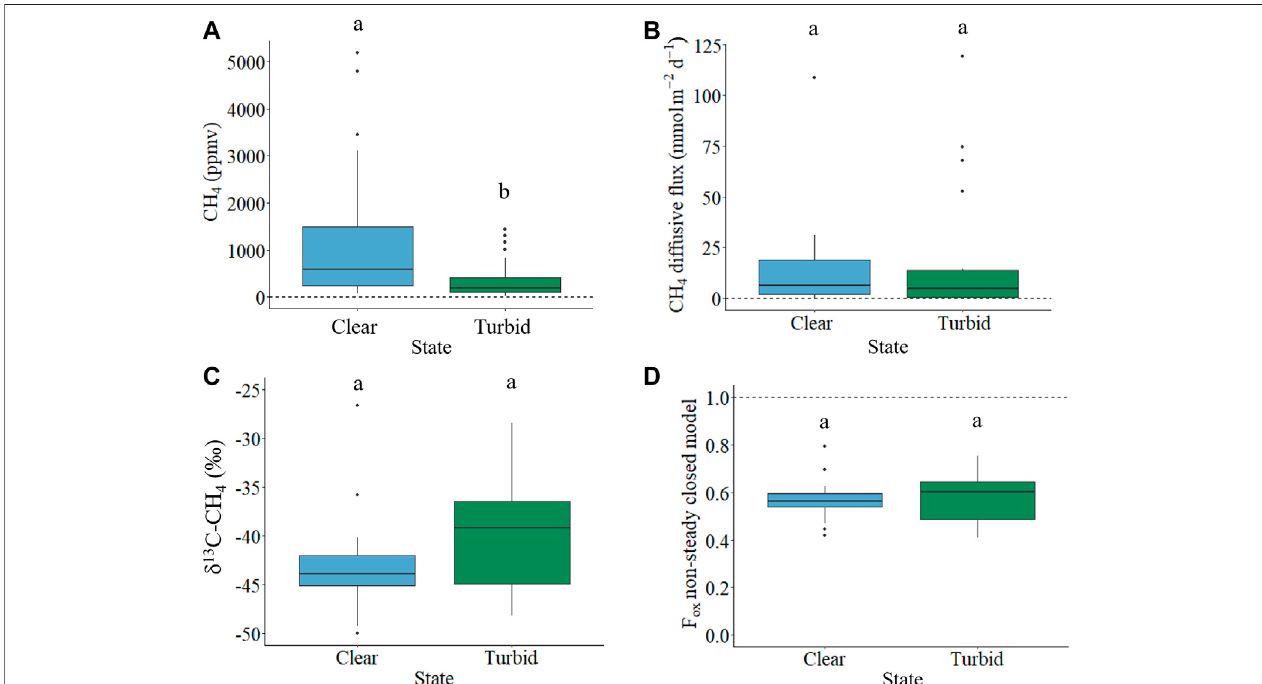
FIGURE2|(A) Meanannualsurfacewater p CH 4 dissolved(ppmv), (B) meanannualCH 4 diffusive fl ux(mmolm − 2 d − 1 ), (C) meanannualCH 4 isotopicsignature( ‰ ) and (D) mean annual Fraction of oxidation (F ox ) obtained with the non-steady closed model, of clear vegetated (blue) and turbid algal (green) shallow lakes, respectively. Different letters (a and b) imply signi fi cant differences between states within the respective panels. The dashed line in panel (A) corresponds to the mean annual atmospheric CH 4 partial pressure (1.71 ppmv), in panel (B) corresponds to a zero CH 4 diffusive fl ux and in panel (D) corresponds to an oxidation of 100%.